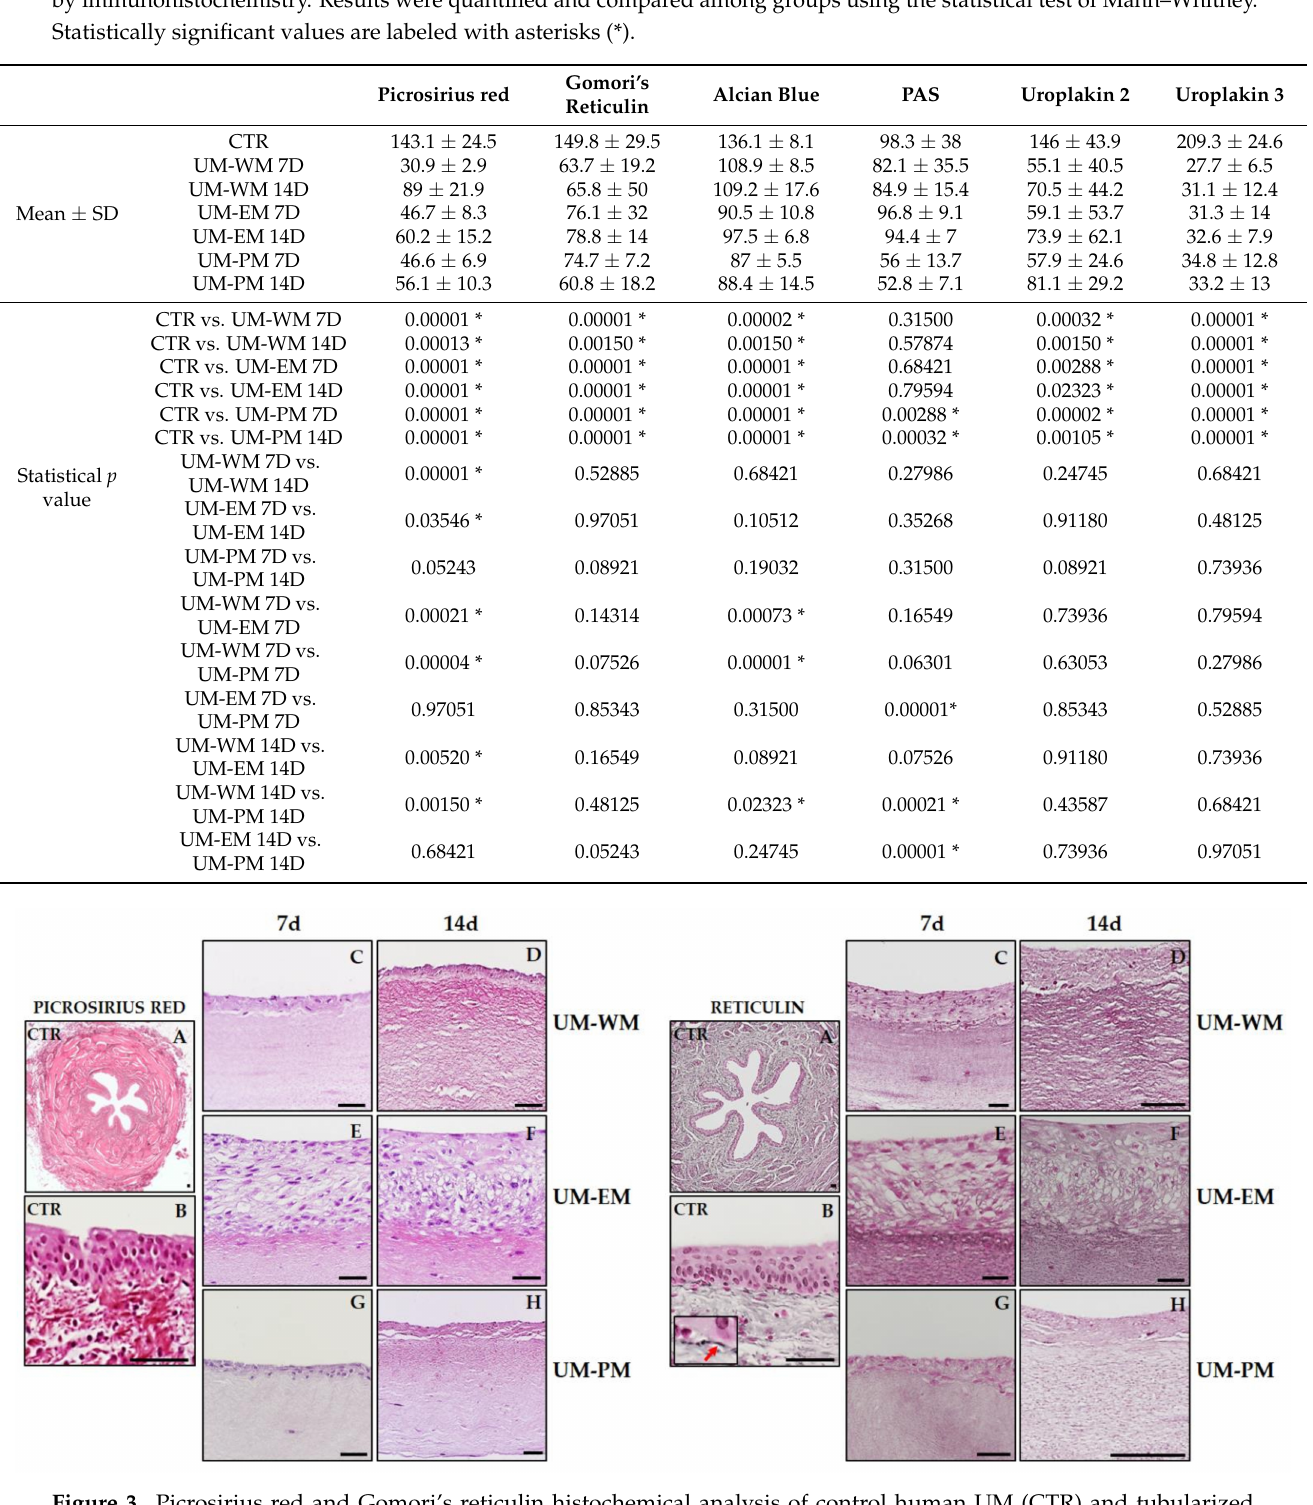
Figure 3. Picrosirius red and Gomori’s reticulin histochemical analysis of control human UM (CTR) and tubularized heterotypical substitutes of the human UM cultured with three different media (WM, EM, and PM) for 7 and 14 days. Illustrative reticular fibers are highlighted with a red arrow in the high-magnification insert in reticulin panel ( B ). Scale bars: 500 µ m in ( A ) and 50 µ m in ( B – H